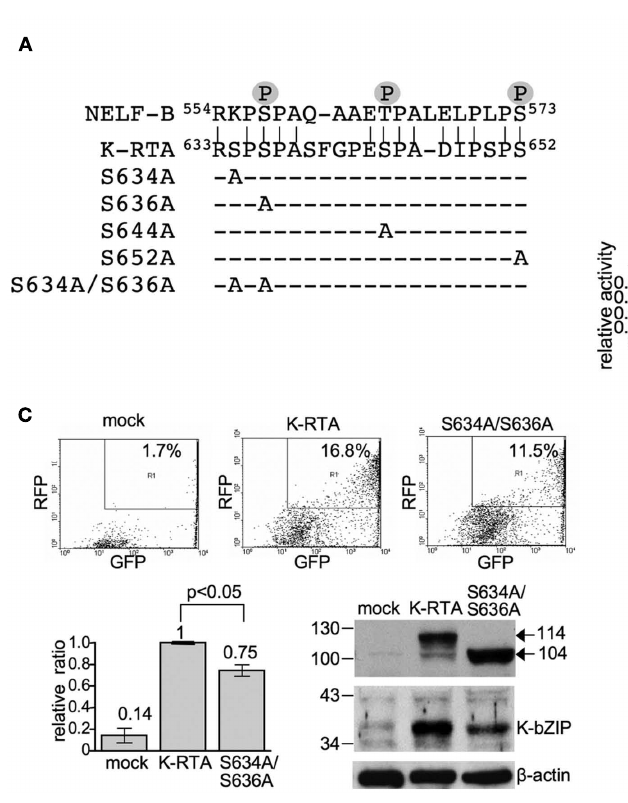
FIGURE 3 | Ser toAla substitutions at Ser-634 and Ser-636 impaired K-RTA transactivation potency and reduced KSHV reactivation. (A) Alignment of a Ser-rich region (amino acids 633–652, 30% Ser) located in the C-terminus of K-RTA with an in vivo phosphorylated peptide derived from negative elongation factor B (NELF-B). In vivo phosphorylated residues in NELF-B identified previously are denoted by circled P (Beausoleil et al., 2004; Olsen et al., 2006). Accordingly, a series of K-RTA variants with mutations in Ser-634, -636, -644, and -652 were generated.The four Ser to Ala mutants and Ser-634 and Ser-636 double mutants are denoted. (B) (Upper) the expression levels and patterns of K-RTA and the nine phosphorylation site mutants were compared in parallel byWestern blot analysis using M2 FLAG antibody. α -tubulin served as a loading control. (Lower) luciferase reporter assay of KSHV PAN promoter responding to the wild type and the phosphorylation mutants transiently expressed in HEK293 cells. Data are presented as the means ± SD for quadruplicate assays.Three independent experiments were performed; a representative result is shown. (C) (Upper) comparison by flow cytometry of potency for viral latency disruption of K-RTA and S634A/S636A. 293/rKSHV.219 cells transfected with K-RTA or S634A/S636A for 72h were analyzed on a